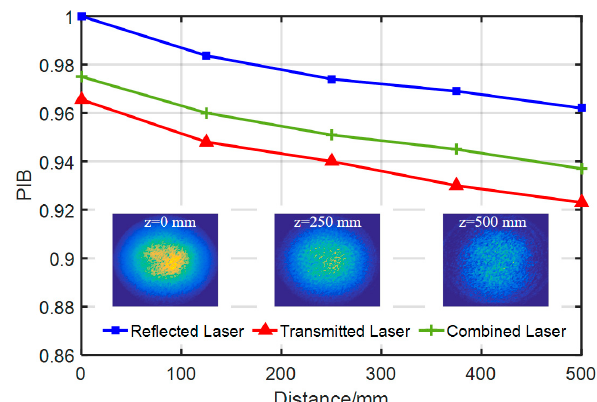
Figure 13. The encircled power versus propagation distance, with a surface roughness of 0.85 nm. The insets display the intensity profiles of the combined beam at different propagation distances.